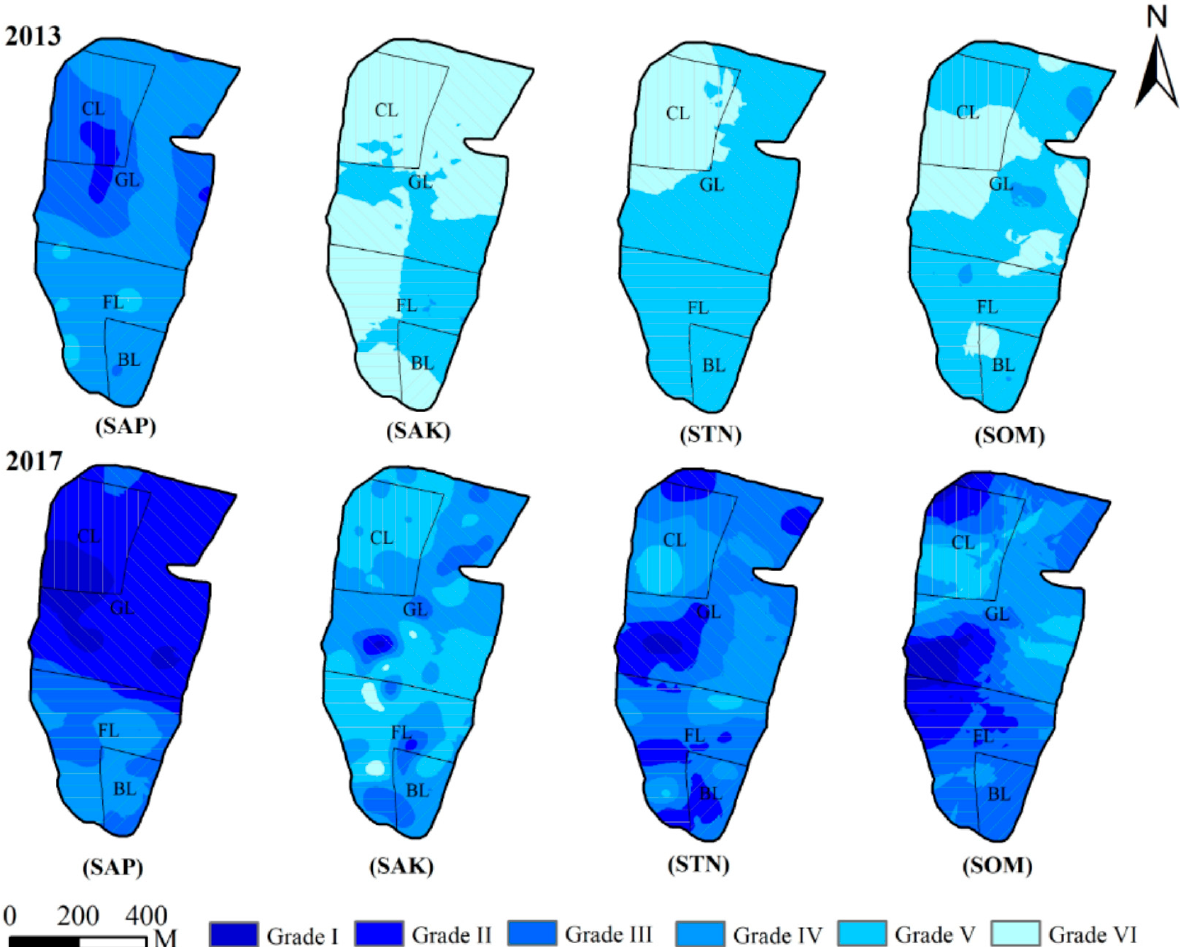
Figure 3. Maps of soil nutrient grades in the study area (CL. Cultivated land; GL. Grassland; FL. Forestland; and BL. Barren land).